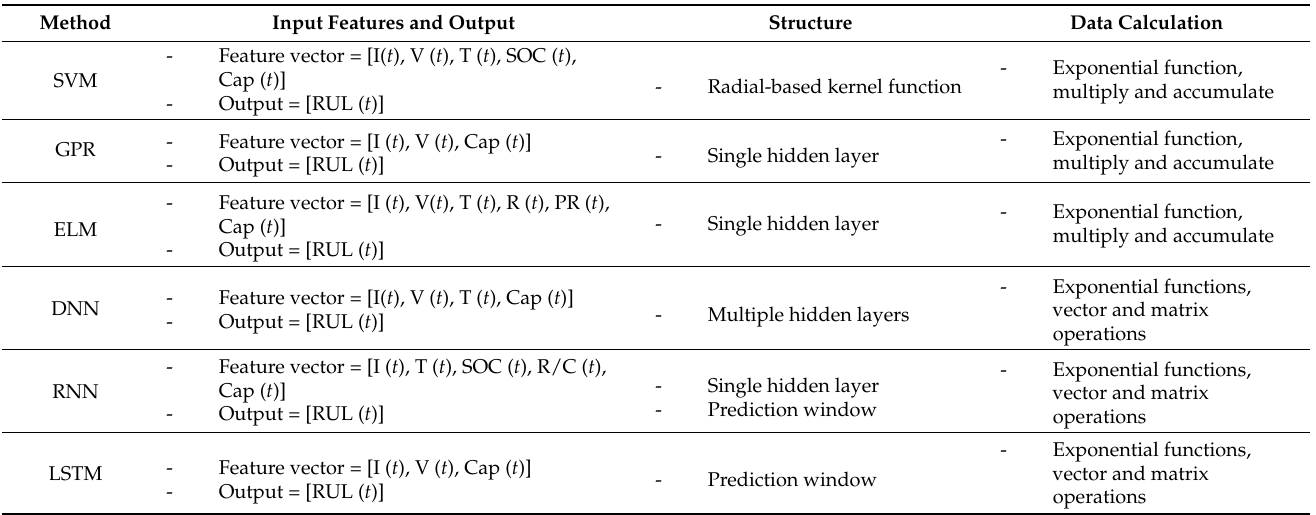
Table 3. Summaries of the different criteria for computational complexity evaluation defined in this section.